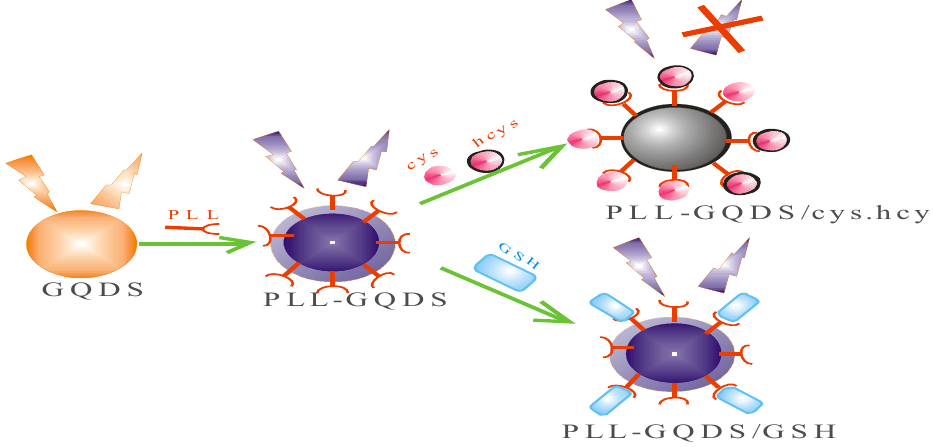
Figure 17. Graphical representation for the detection of cysteine ( cys ) and homocysteine ( hcys ) using PLL-GQDs.